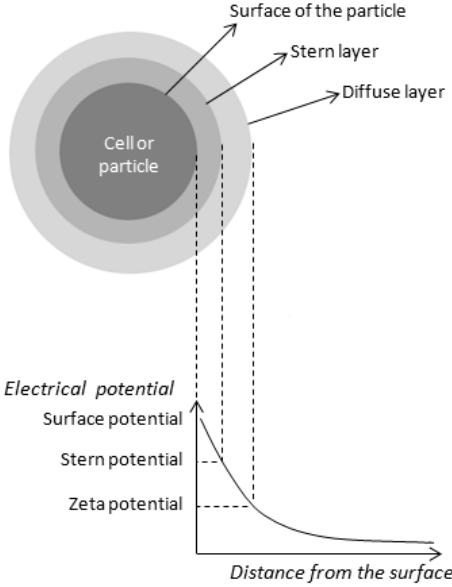
Figure 1. Scheme of double layer compression (DLVO theory).